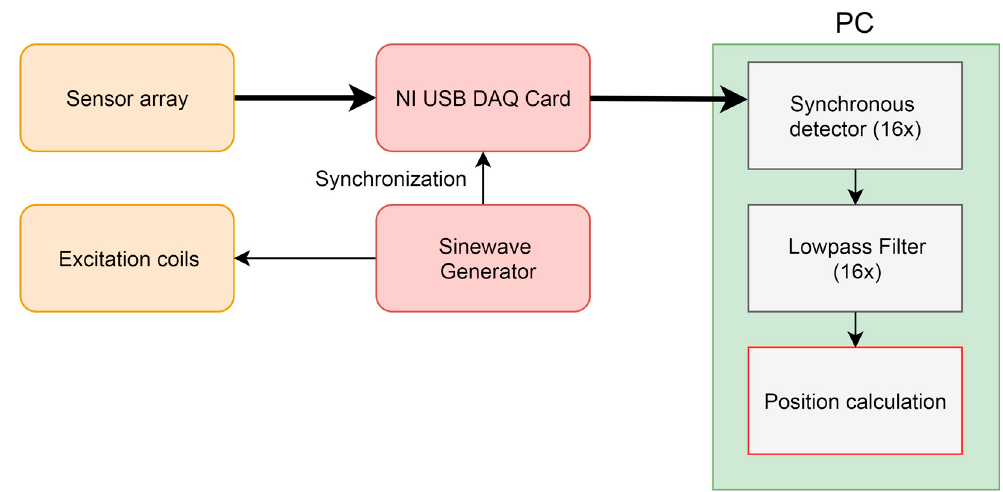
Figure 4. Schematic diagram of signal processing.